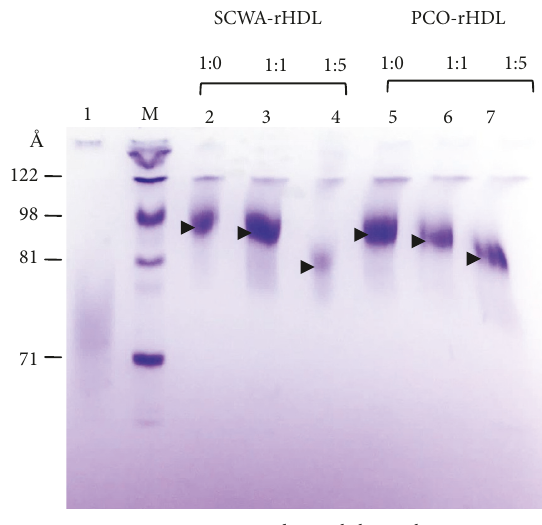
Figure 1: Electrophoretic patterns of rHDL by native electrophoresis (8-25% native polyacrylamide gradient gel) after synthesis of reconstituted HDL with apoA-I and either PCO or SCWA. Lane 1, lipid-free apoA-I; lane M, molecular weight marker; lane 2, SCWA-rHDL (1:0); lane 3, SCWA-rHDL (1:1); lane 4, SCWA-rHDL (1:5); lane 5, PCO-rHDL (1:0); lane 6, PCO-rHDL (1:1); lane 7, PCO-rHDL (1:5). Table 1: Characterization of rHDL containing PCO or SCWA by spectroscopic analysis. SCWA-rHDL PCO-rHDL Lipid free apoA-I